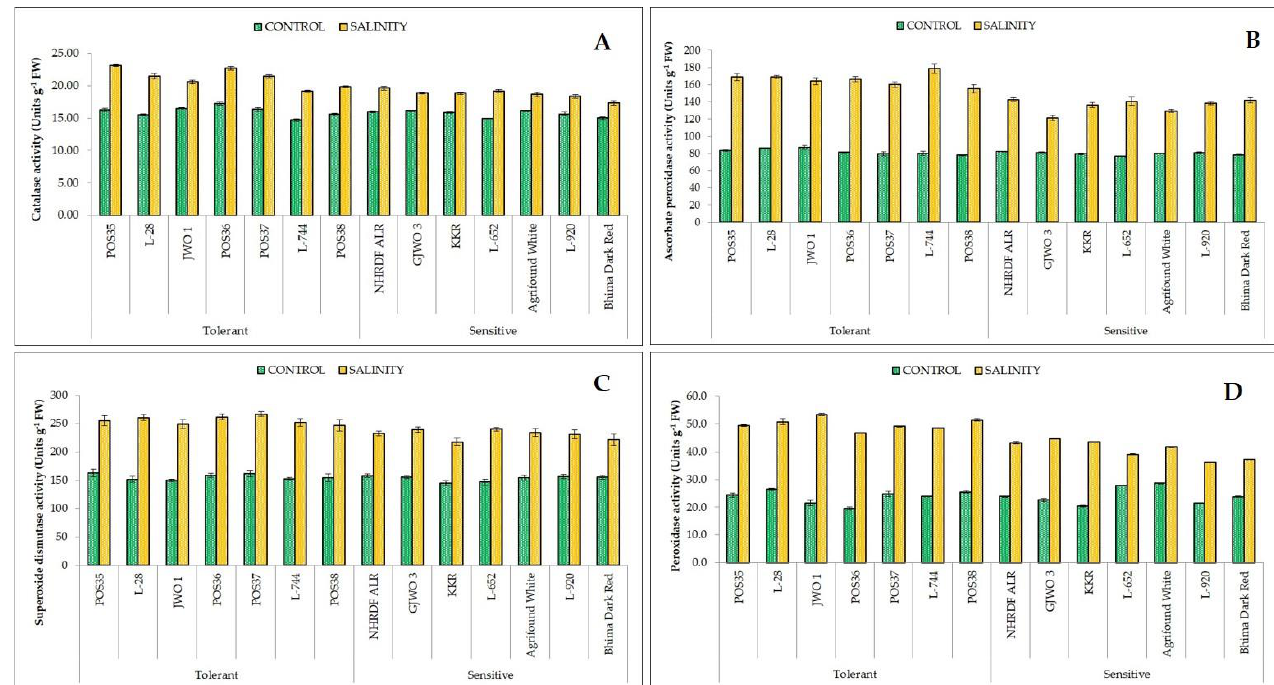
Figure 4. Antioxidative enzymes activity (CAT, ( A ); APX, ( B ); SOD, ( C ); and POX, ( D )) of selected onion accessions under control and salinity. Table 7. Relative contribution of different physiological, biochemical, and yield-related traits toward genetic divergence in onion